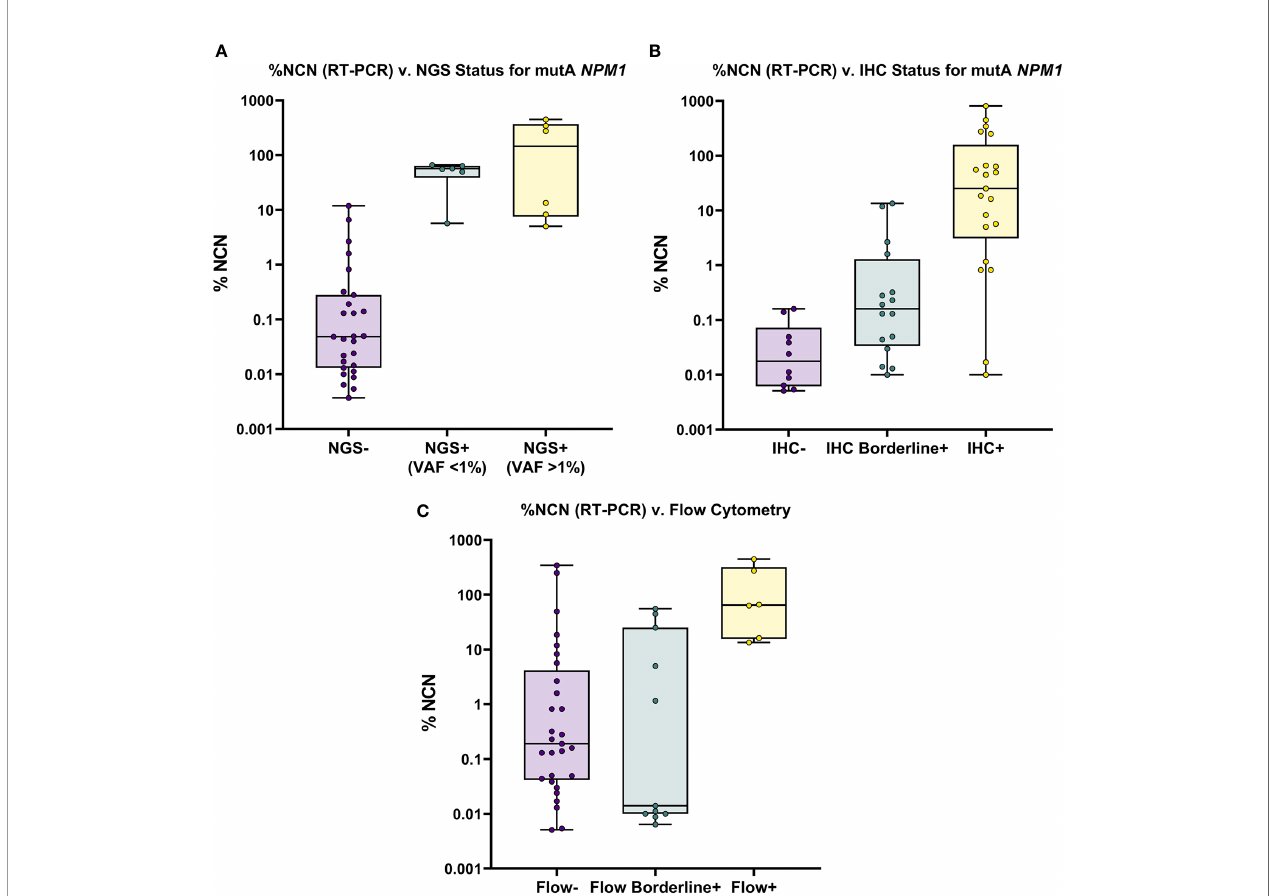
FIGURE 1 | Overview of NGS, IHC and FC Results for All RT-PCR Positive Samples. (A) Mutant (Type A) NPM1 RT-PCR (%NCN) ( plotted on Log 10 scale ) is shown compared to NGS results; samples are grouped by NGS status (i.e., Negative, <1% VAF and >1% VAF). Samples are noted to be detectable by NGS only when RT-PCR % NCN values are ≥ 5%. (B) Mutant (Type A) NPM1 RT-PCR (%NCN) is shown compared to IHC results; samples are grouped by IHC status (i.e., Negative, Borderline Positive and Positive). In general, mutant NPM1 protein is detectable (i.e., Positive) by IHC when RT-PCR % NCN values are ≥ 1% (although occasional samples may show detectable mutant NPM1 protein by IHC at lower % NCN values (i.e., 0.01-1% NCN). (C) Mutant (Type A) NPM1 RT-PCR (%NCN) is shown compared to FC results; samples are grouped by FC status (i.e., Negative, Borderline Positive and Positive). In general, samples are Positive by FC only when RT- PCR % NCN values are >10% (although occasional samples may show borderline FC positivity at lower % NCN